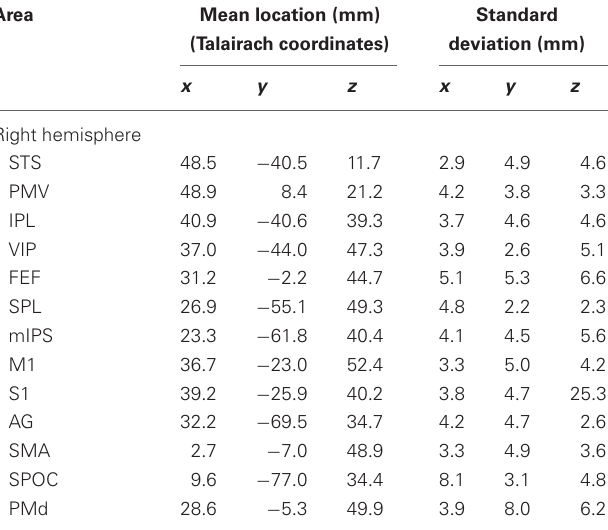
Table 3 | Mean location and standard variation of the regions across all 10 subjects for the right